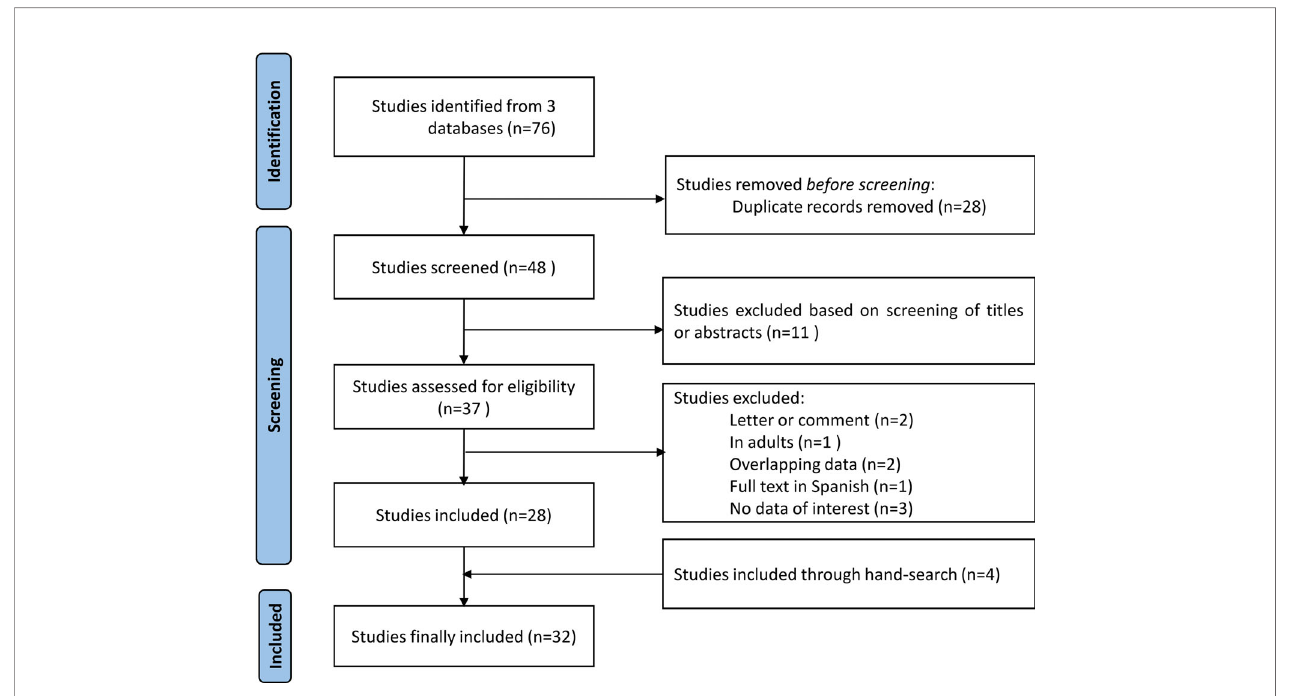
FIGURE 1 | PRISMA fl owchart of study